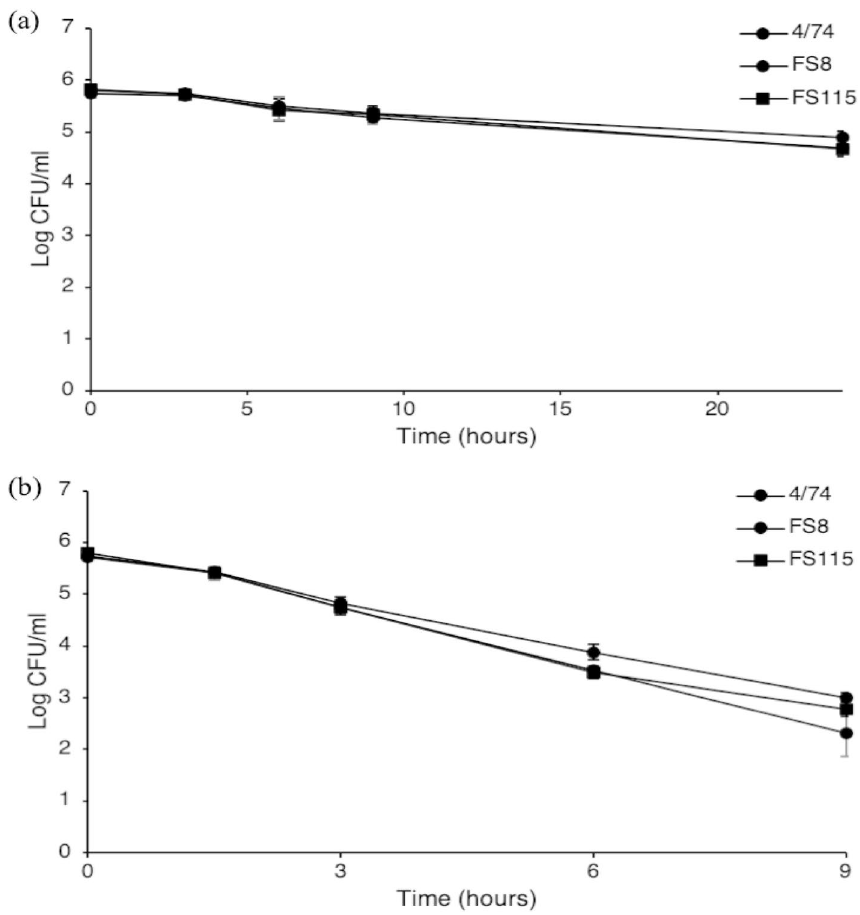
Figure 1. In vitro inactivation of S. Typhimurium 4/74, FS8 and FS115 in TSB adjusted to pH 3.5 with HCl 6 N at 4 °C ( a ) and 37 °C ( b ). Each data point is a mean of 6 replicates (± standard